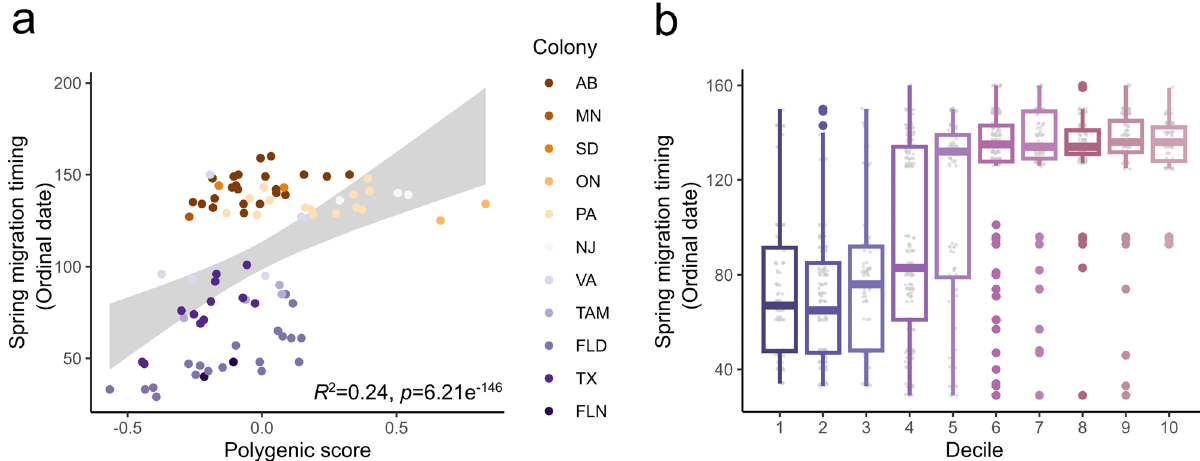
Figure 2. ( a ) Polygenic scores of spring migration timing for purple martins ( n = 87) colored in order by latitude, and linear regression 95% confidence interval is colored in gray. ( b ) Predicted polygenic scores (PGS) partitioned by decile (lowest PGS = decile 1, highest PGS = decile 10), showing individuals (raw points in gray dots and results summarized in box plots) in lowest deciles had earlier migration timing compared with individuals in higher deciles with later